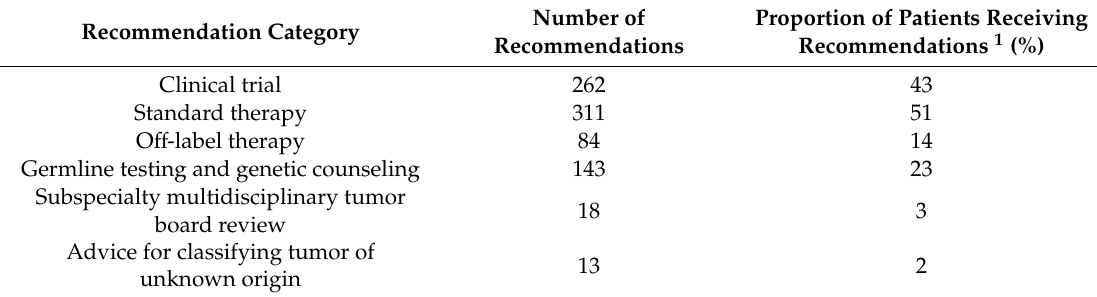
Table 1. Recommendations by category from the MTB for all patients analyzed ( n =